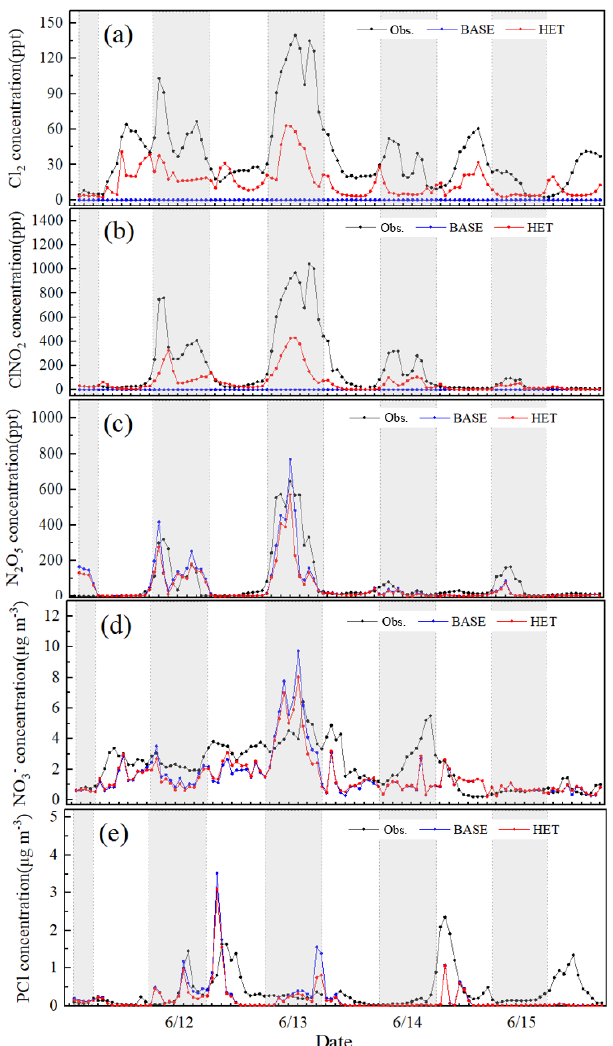
Figure 1. Comparison of observed hourly Cl 2 , ClNO 2 , N 2 O 5 (at the Institute of Atmospheric Physics, Chinese Academy of Sciences), NO − and PCl (at Tsinghua University) in urban Beijing with pre- 3 dictions from the BASE and the HET cases during 11–15 June